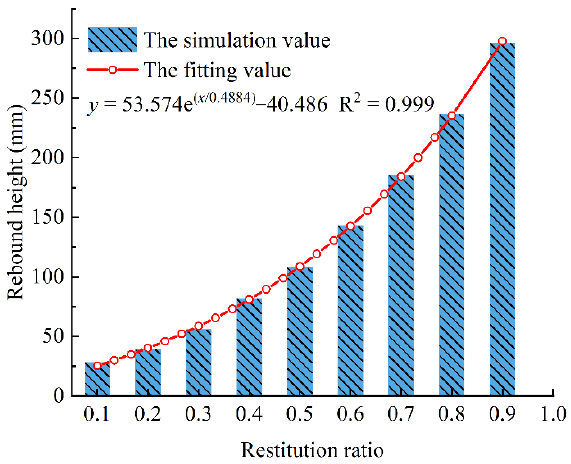
Figure 5. Relationship between RC and H 1 .